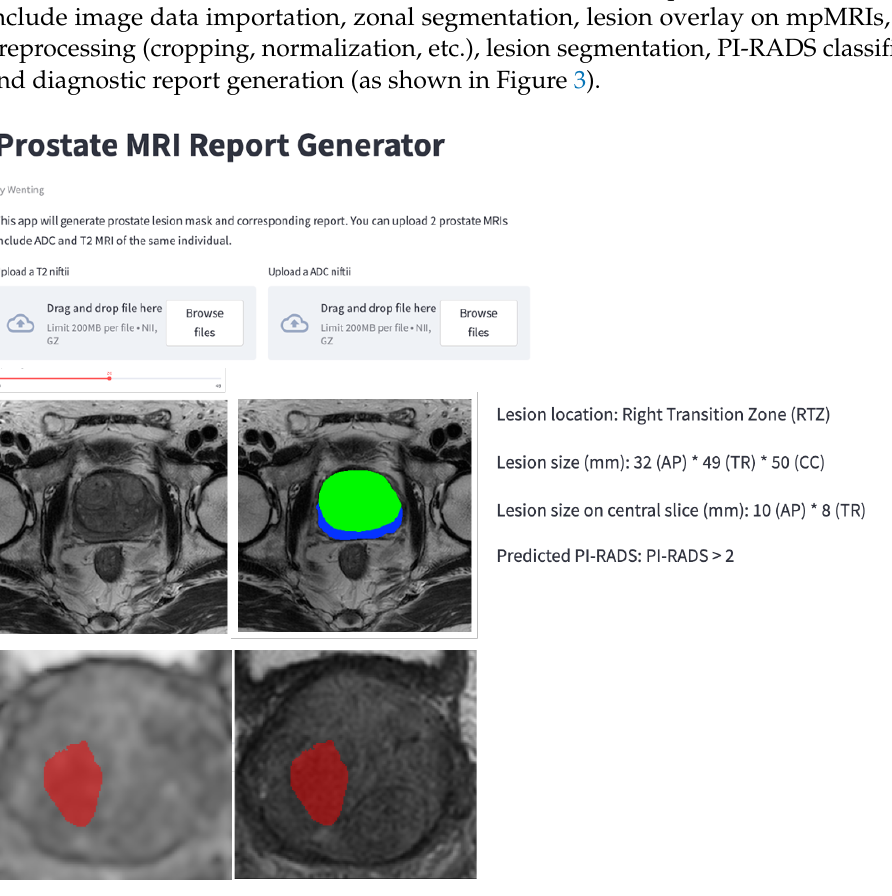
Figure 3. Graphical user interface (GUI) for automatic detection, PI-RADS classification, and diag- nostic report generation of prostate cancer on